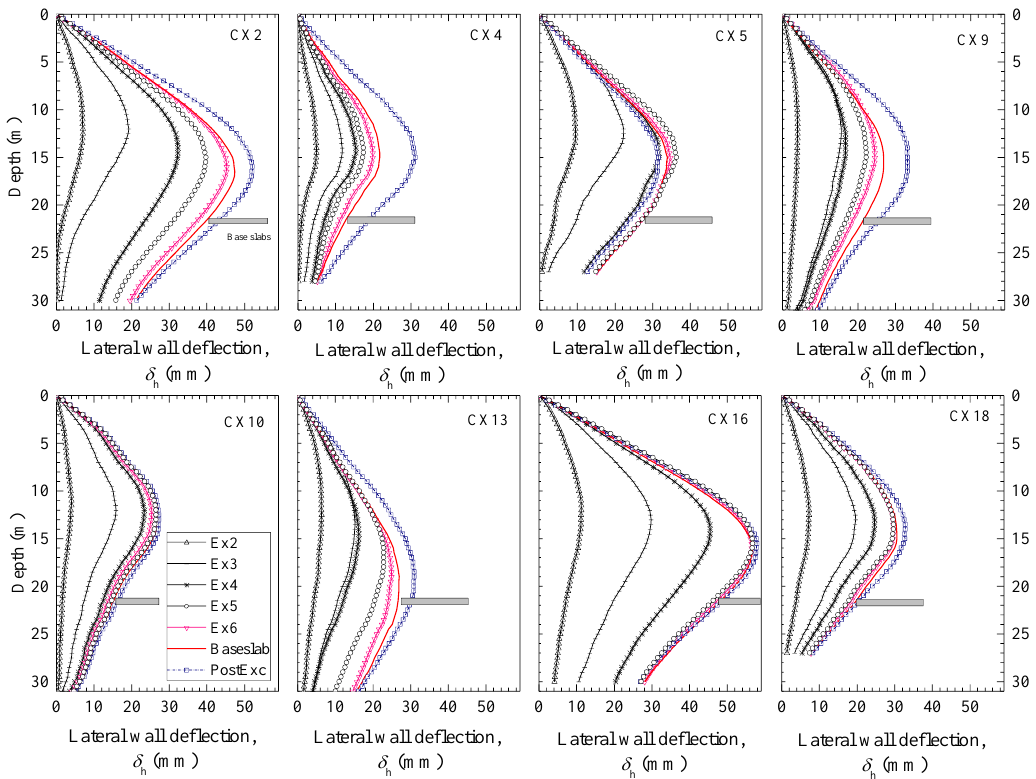
Figure 5. Lateral deflections of diaphragm wall.